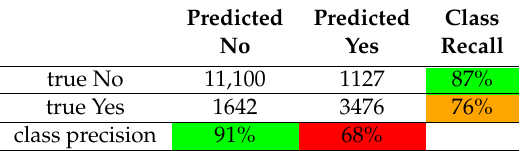
Table 8. Confusion matrix for DNN for Normal class.